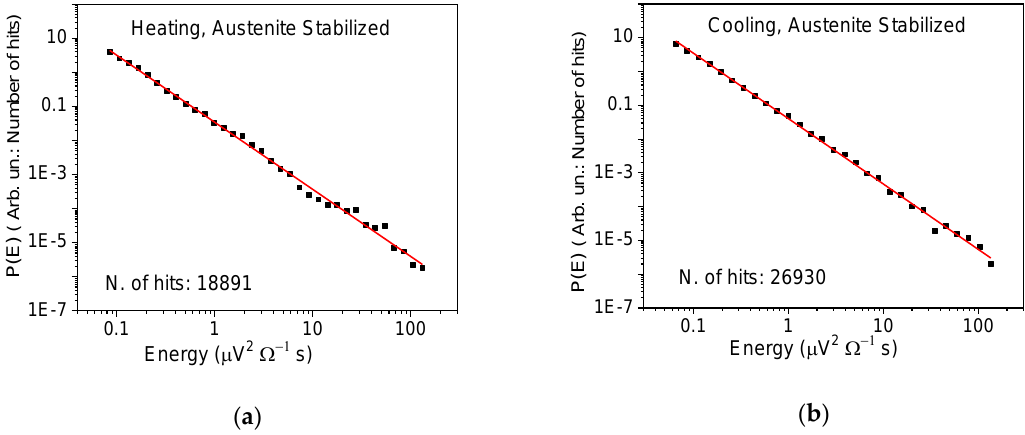
Figure 6. Energy distribution functions; Log P versus log E, obtained from acoustic measurements during heating ( a ) and cooling ( b ) in quenched Ni 51 Fe 18 Ga 27 Co 4 single crystal .